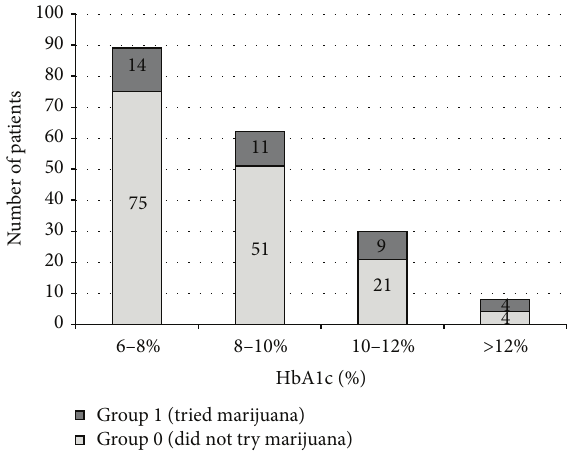
Figure 1: The proportion of patients who tried or did not try marijuana, according to HbA1c levels, 𝑝 = 0.03 ; response rate to that question was